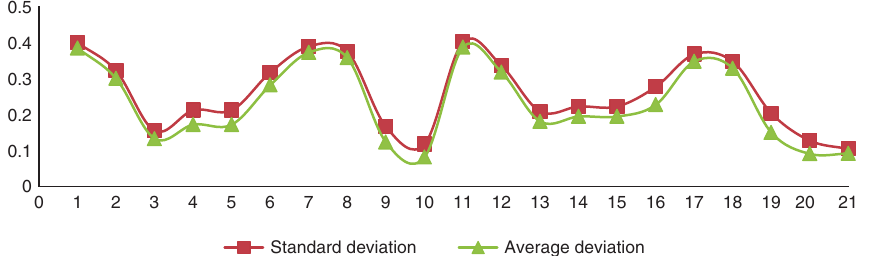
Figure 3: Standard/Average Deviation Results for Proposed 21 Measures on Score Classes 0–1 with MSR Paraphrase.